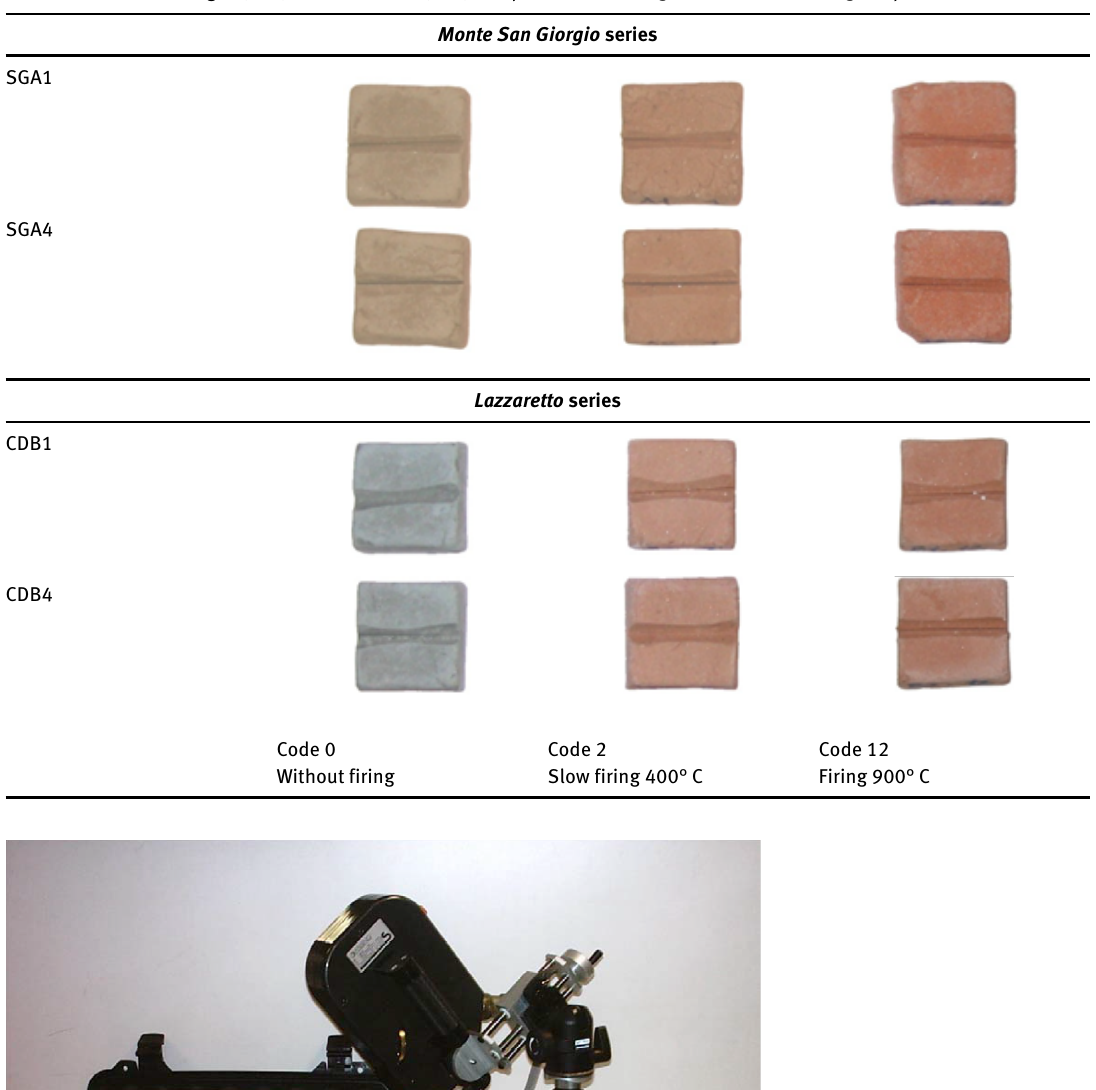
Table 1. Monte San Giorgio (SGA) and Lazzaretto (CDB) samples without firing and at different firing temperatures.